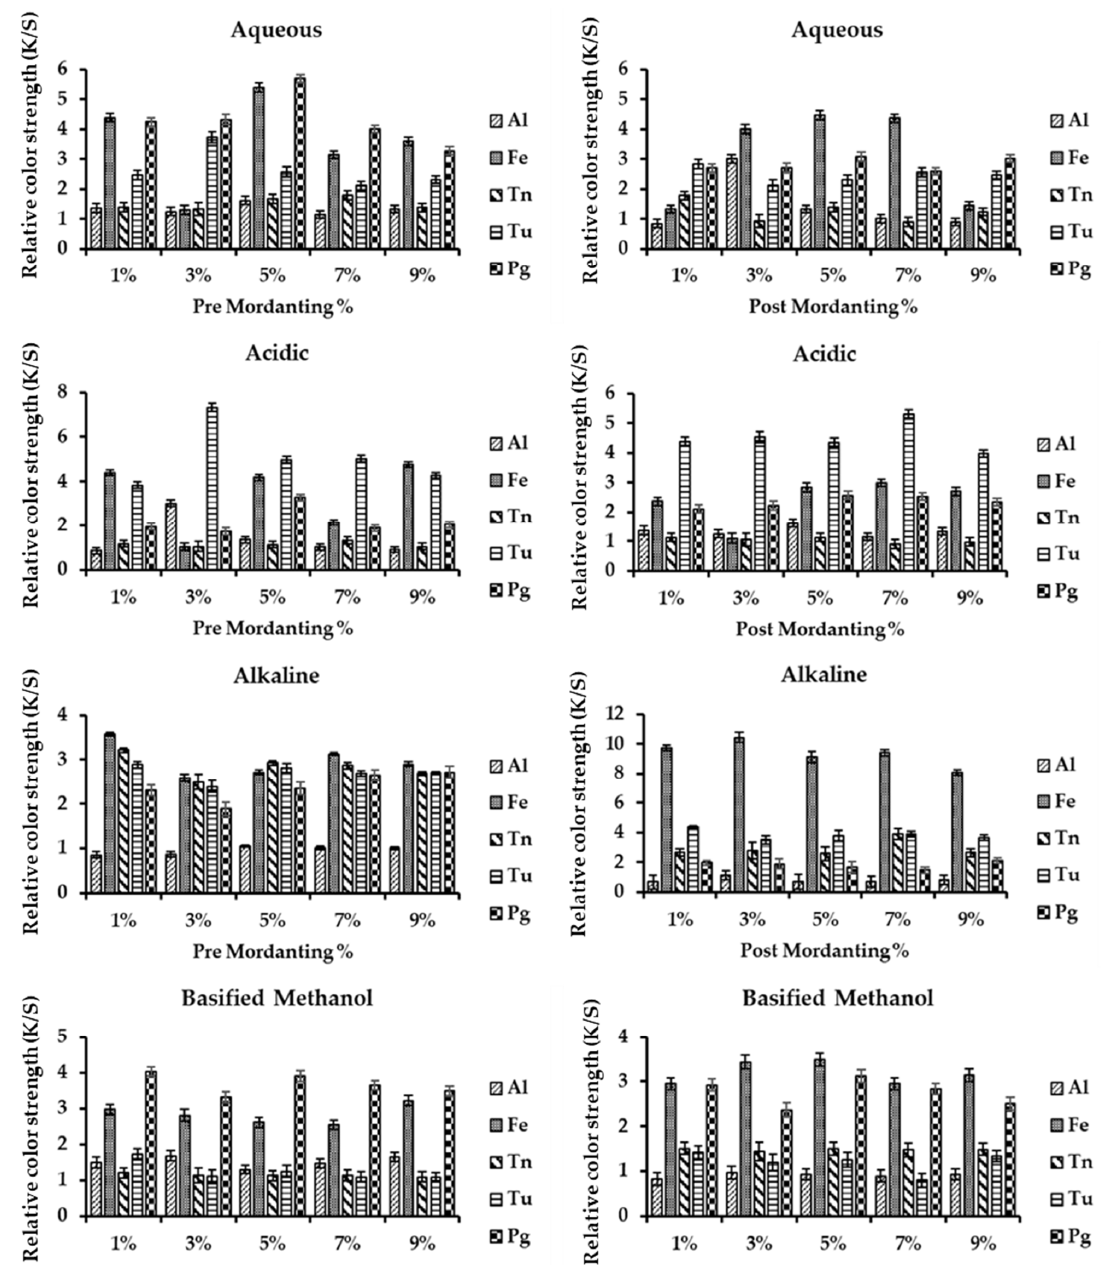
Figure 8. Dyeing of pre-mordanting and post-mordanting wool using aqueous, acidic, alkaline, and basified methanol rose extracts respectively. Al +3 , aluminum; Fe +2 , iron; Tn, tannic acid; Tu; turmeric; Pg, pomegranate.